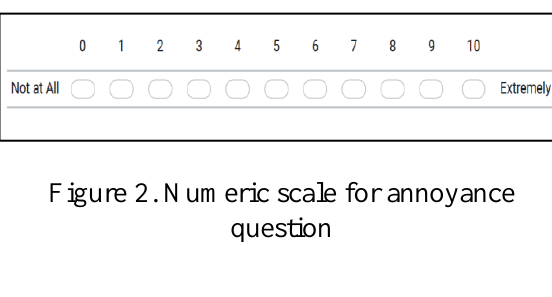
Figure 1. Verbal scale for annoyance question